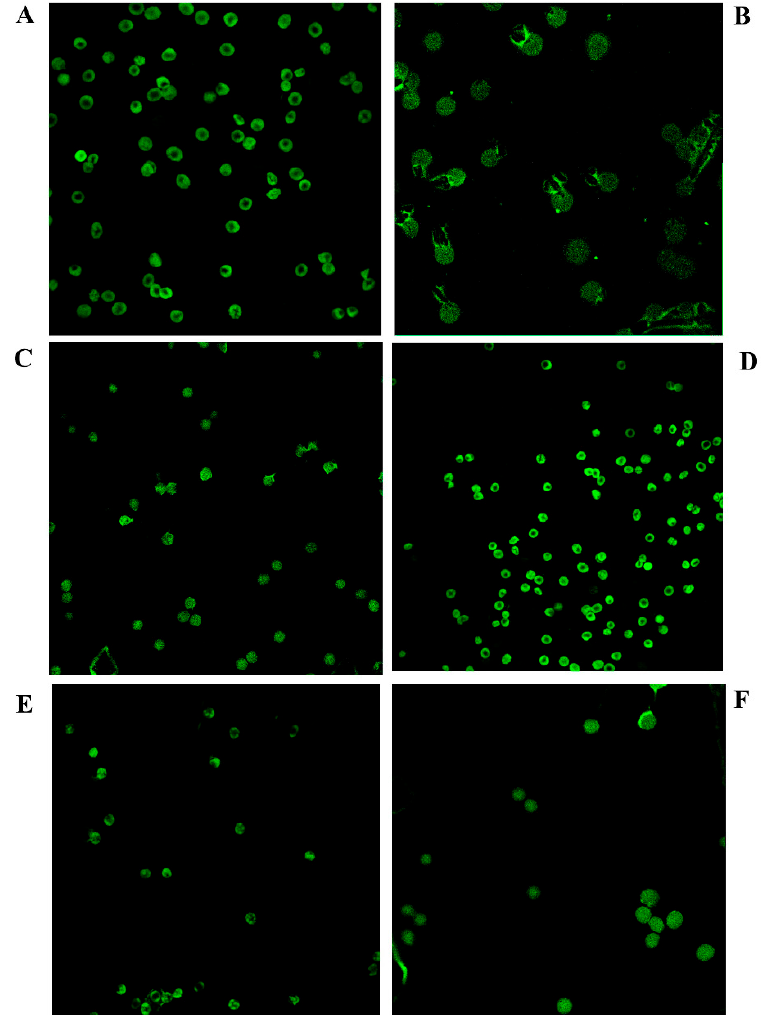
Figure 7. Peel and pulp extracts of Feijoa reduce microvesicles (MV) released from RBC. Untreated cells are shown in ( A ). Cells were treated with 40 µ M HgCl 2 for 4 h ( B ) and concurrently treated with 20 or 80 µ g / mL of Feijoa peel ( C and D , respectively) and pulp ( E and F , respectively) extracts. RBC were stained with Annexin V-FITC.